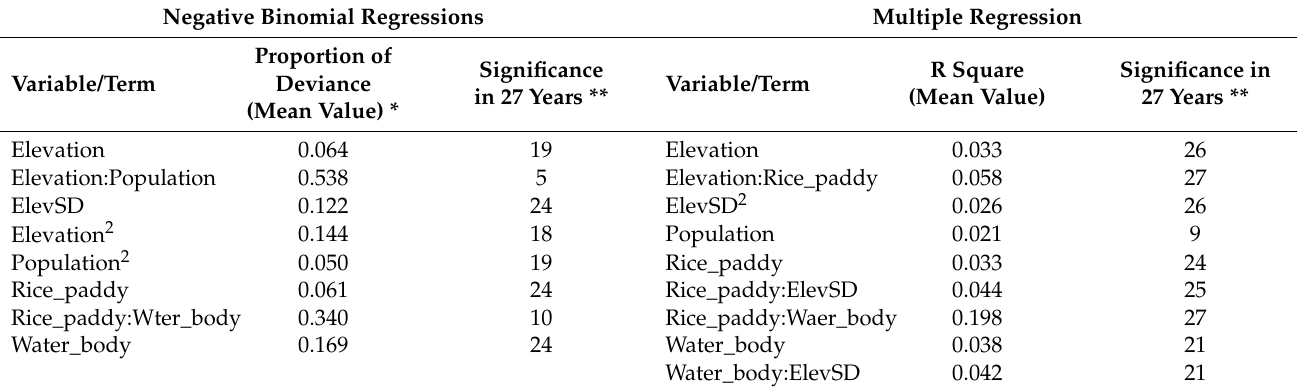
Table 2. The most important variables and terms in negative binomial regressions and multiple regression that fit number of nests in watersheds by environmental variables.